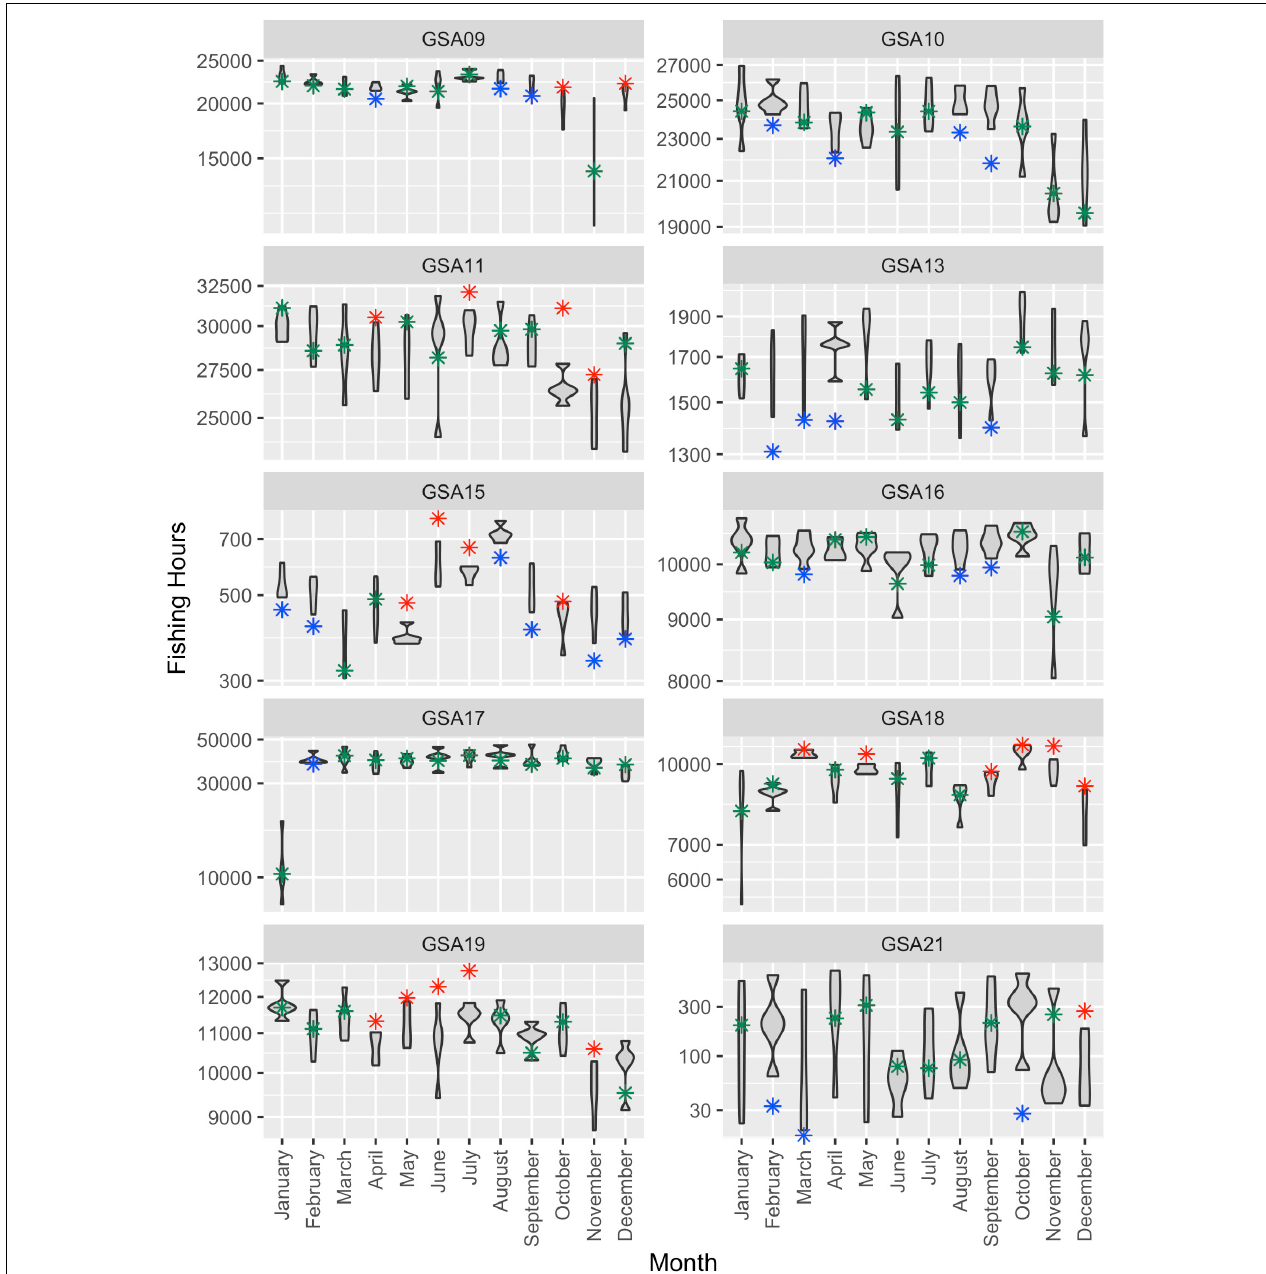
FIGURE 3 | Violin plot of the values of total Fishing Effort (in Hours) by month and GSA. The values of the years 2015–2019 are represented by the violin, while medians of the year 2020 (during the pandemic) are represented as asterisks colored in red when significantly higher than those in the reference period, in blue when significantly lower than those in the reference period and in green when coherent with those in the reference